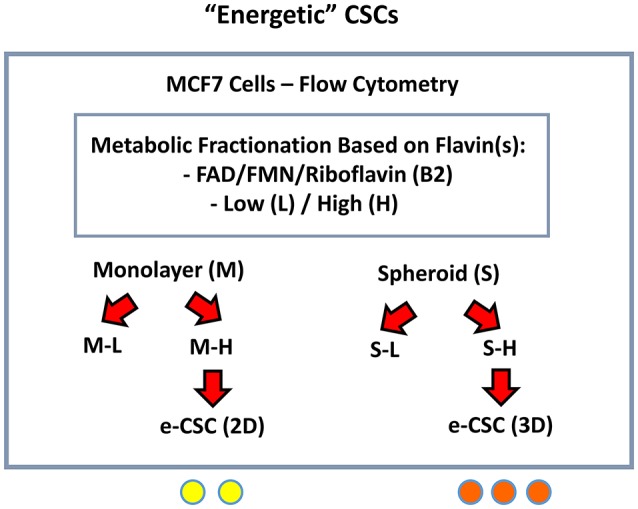
Detecting and purifying “energetic” CSCs (e-CSCs). In order to isolate CSCs, single cell suspensions of MCF7 cells were first subjected to metabolic fractionation by flow cytometry, based on the endogenous auto-fluorescence (AF) of FAD/FMN, high-energy metabolites. The high (H) and low (L) sub-populations of AF cells were then collected from MCF7 cells grown either as (i) 2D-monolayers or (ii) 3D-spheroids. These “high-energy” AF(+) cells were then designated as: e-CSCs (2D) and e-CSCs (3D).